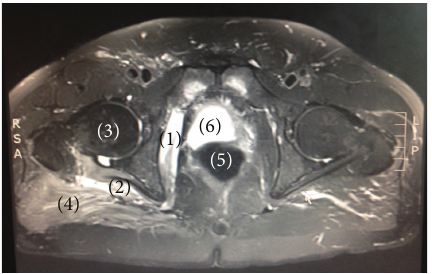
Figure 2: Signal abnormality of the right short external rotators on axial section of T2-weighted MRI. (1) Obturator internus. (2) Quadratus femoris. (3) Head of femur. (4) Gluteus maximus. (5) Rectum. (6) Bladder.